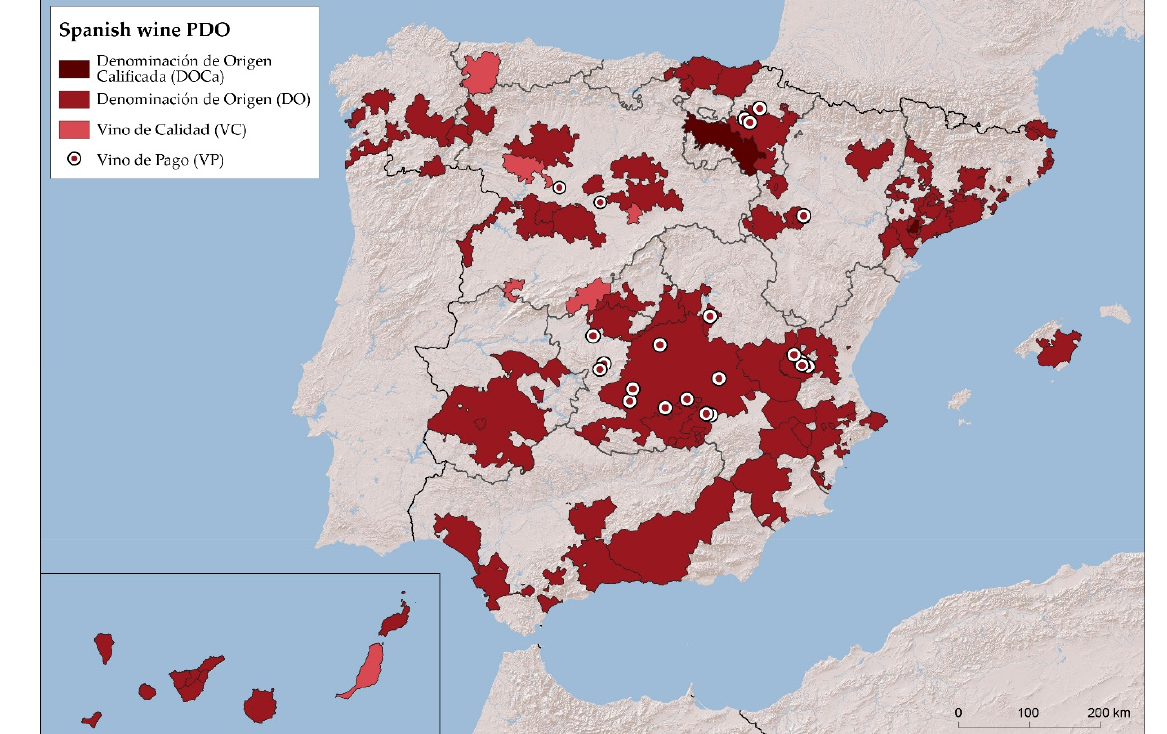
Figure 11. Spanish wine PDO registered in the European Union. Source: European Commission. eAmbrosia. The EU geographical indications register. Retrieved from: https://ec.europa.eu/geographical-indications-register/ (accessed on 14 March 2022) and Spanish Ministry of Agriculture, Fisheries and Food. Own elaboration.